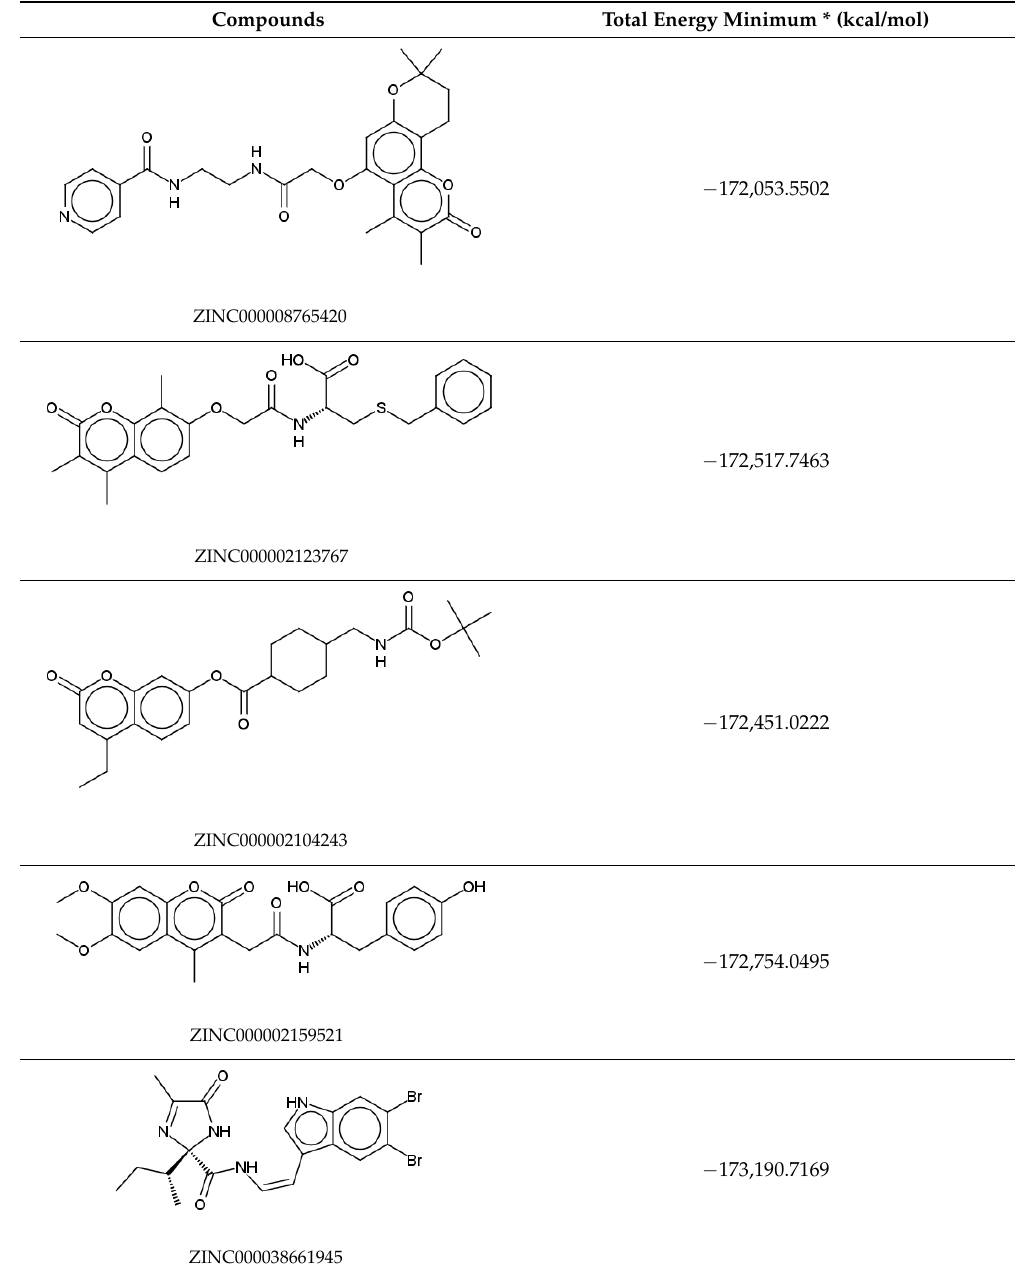
* The value for AChE without ligand is − 172,691.7383